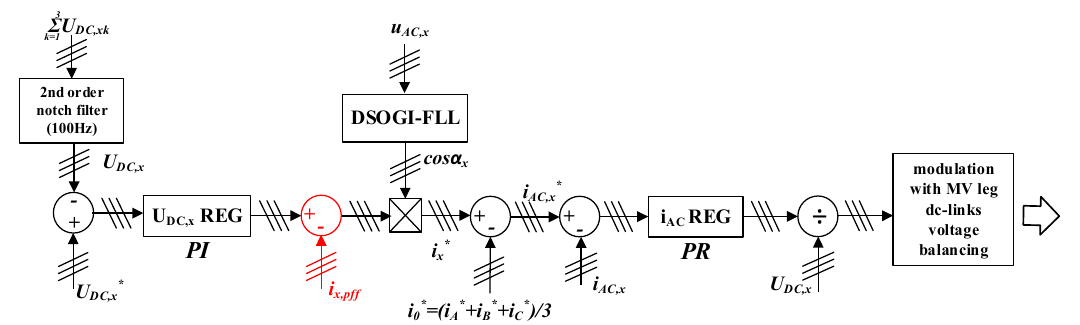
Figure 6. Scheme of chosen topology for ST’s MV-AC/MV-DC and MV-DC/LV-DC converters.